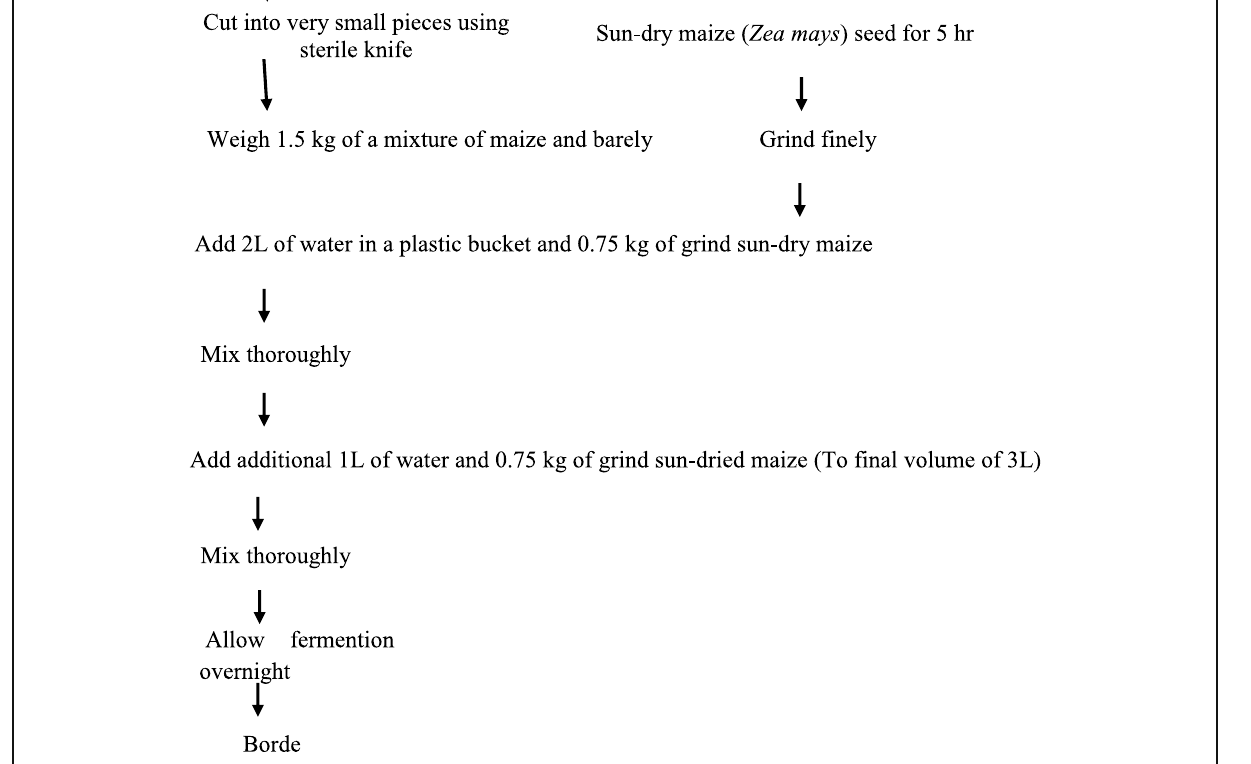
Fig. 1 Flow chart of preparation of borde (this